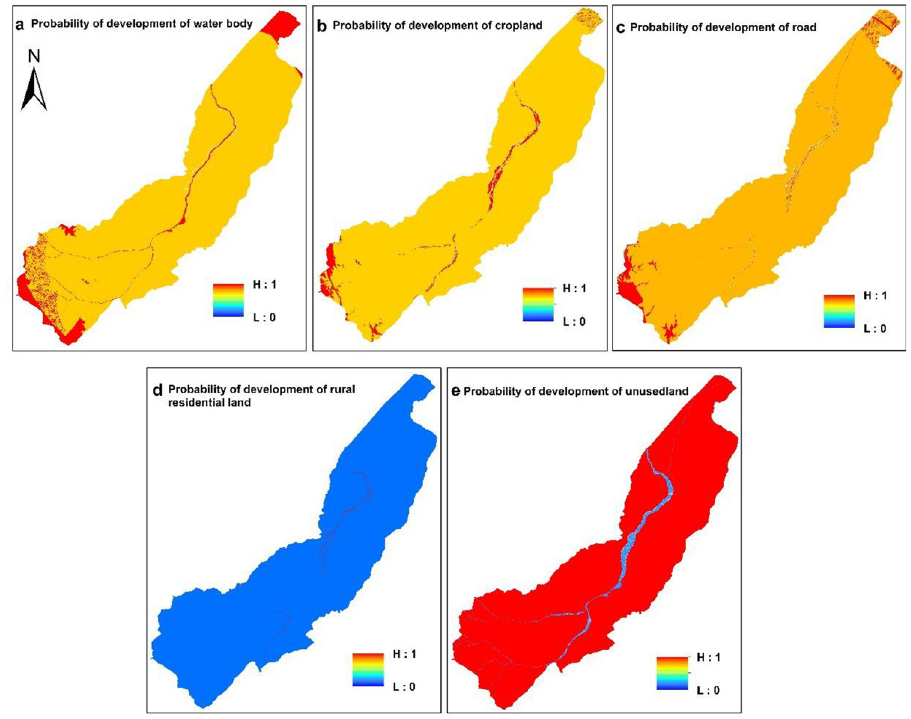
Fig 7. Development probability of land in QPT. (Software: ArcMap 10.2.0, http://www.esri.com).